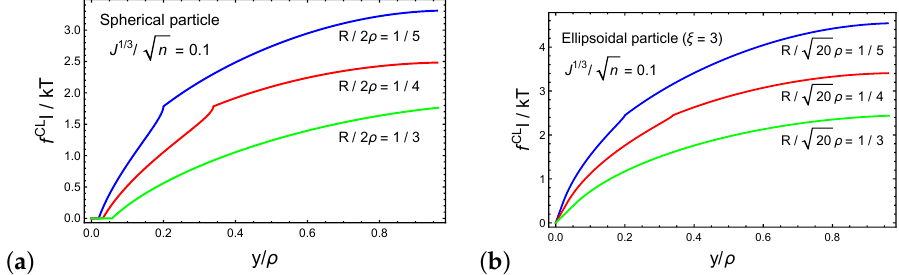
Figure 6. The force on a cross-link f CL for ( a ) a spherical particle and ( b ) an ellipsoidal particle (cross-link 1) as a function of the normalized sink y / ρ . We set the ratio J 1/3 /